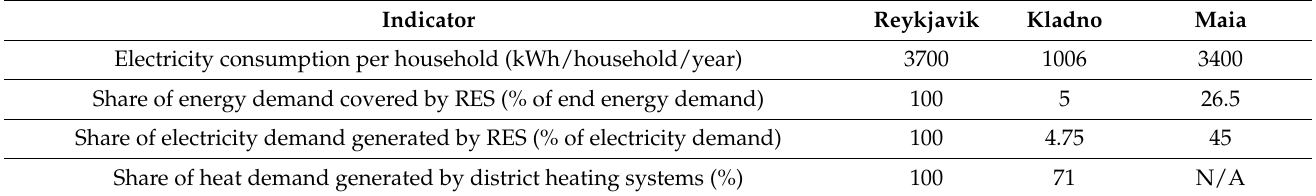
Table 4. Sample energy indicators for SPARCS fellow cities: Reykjavik, Kladno and